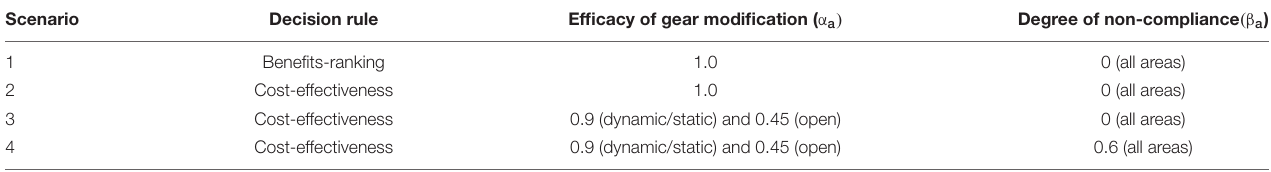
TABLE 3 | Criteria for management decision rules in optimization framework, by scenario (Eqs. 1 and 2). Scenario